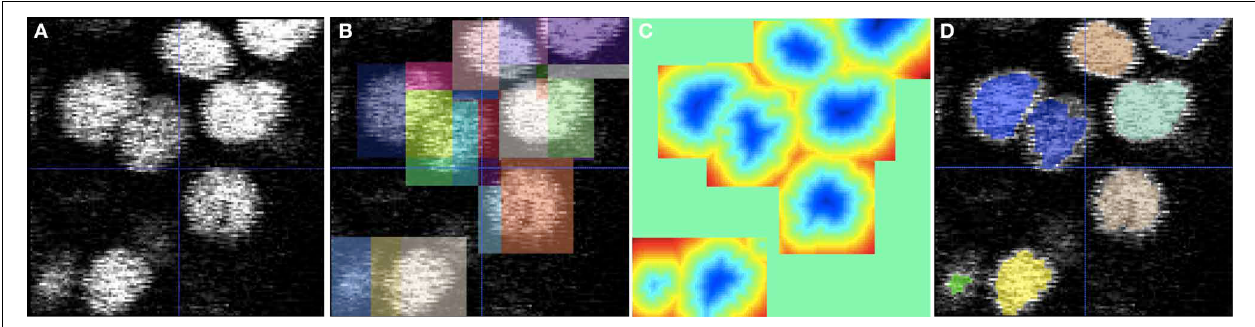
FIGURE 4 | Cell segmentation using multiple level-sets defined on subsets of the image domain. (A) 2D confocal image of cell nuclei in the zebrafish ear. (B) Square domains defined around approximate centers of each cell. (C) Visualization of the